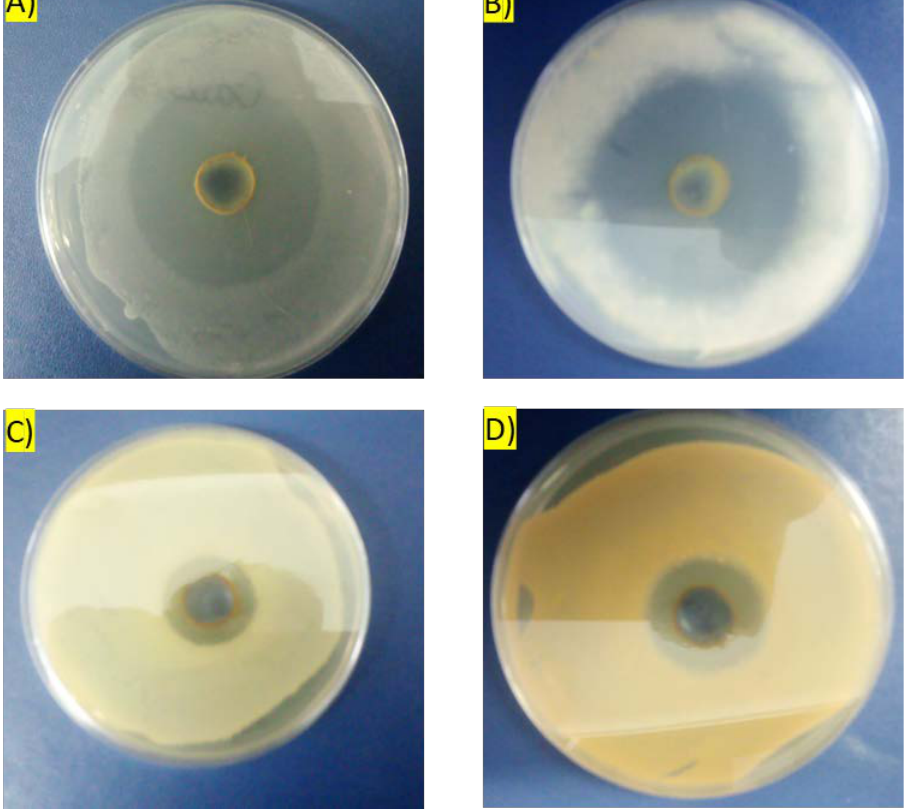
Figure 4. Antimicrobial activity of aqueous extract of Chlorella vulagris : ( A ) Aspergillus niger , ( B ) Candida albicans , ( C ) Escherichia coli , ( D ) Staphylococcus aureus .